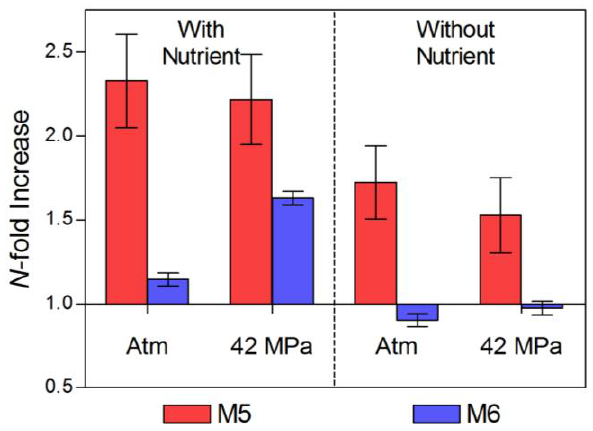
Figure 3. Change in total prokaryotic abundance ( N -fold increase) relative to time zero. Atm: Atmospheric pressure; M5: High chlorophyll (red); M6: Low chlorophyll (blue). Error bars represent the standard error of the mean.